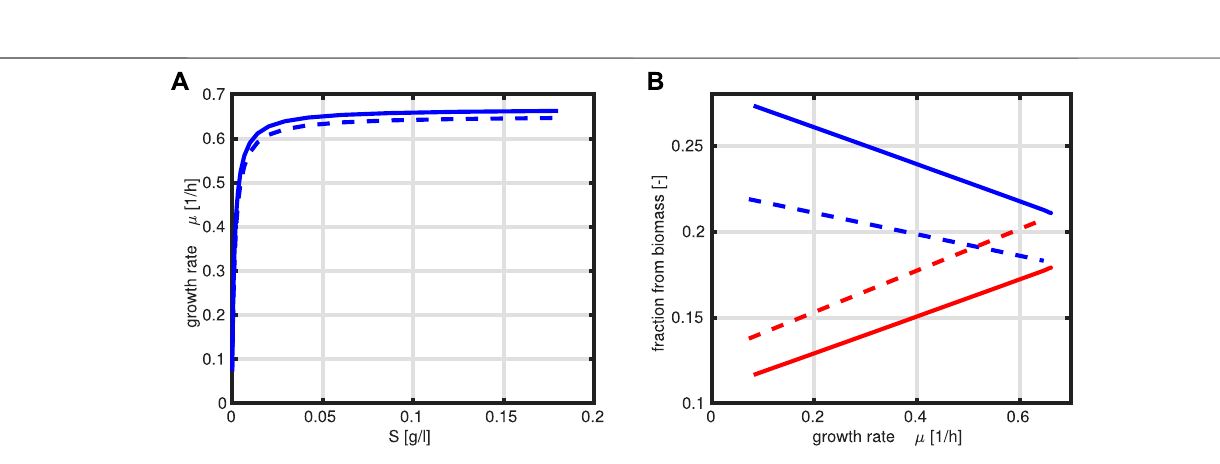
FIGURE4| Speci fi cgrowthrate μ asafunctionofsubstrate S ,wherethesolidlinerepresentstheoptimalcase (A) .Fractions R (red)and T (blue)asafunctionofthe growth rate μ , where the solid line represents the optimal case, and dashed lines are from presented data in Figure 3B .